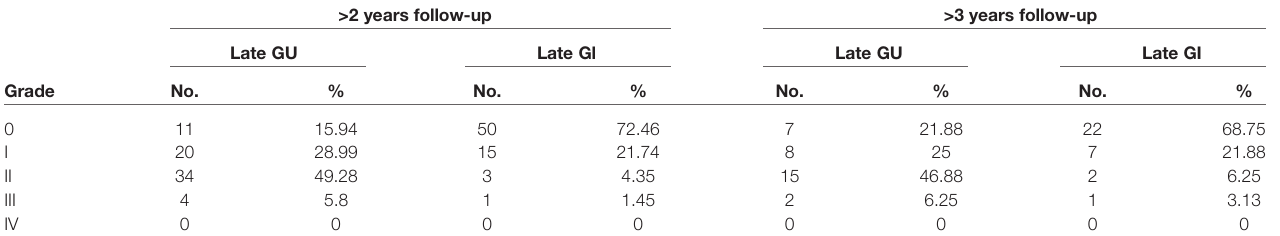
(A) All patients. (B) Strati fi ed by follow-up years. At a median follow-up of 14.9 months, acute urinary grade II toxicity occurred in 20.4% of patients. Acute grade II GI toxicity occurred in 7.3%ofpatients. Lategrade ≥ II GItoxicity occurredin3.6%ofpatients. Onepatient hadgradeIII(0.4%)GItoxicity, andanotherhadgradeIVGItoxicity(0.4%). Noacutegrade ≥ IIIGUor GI toxicity was noted. (A). For follow-up > 2 years (n = 69), late GU and GI grade ≥ III toxicity occurred in 5.8% and 1.5% of patients, respectively (B). GU, genitourinary; GI,